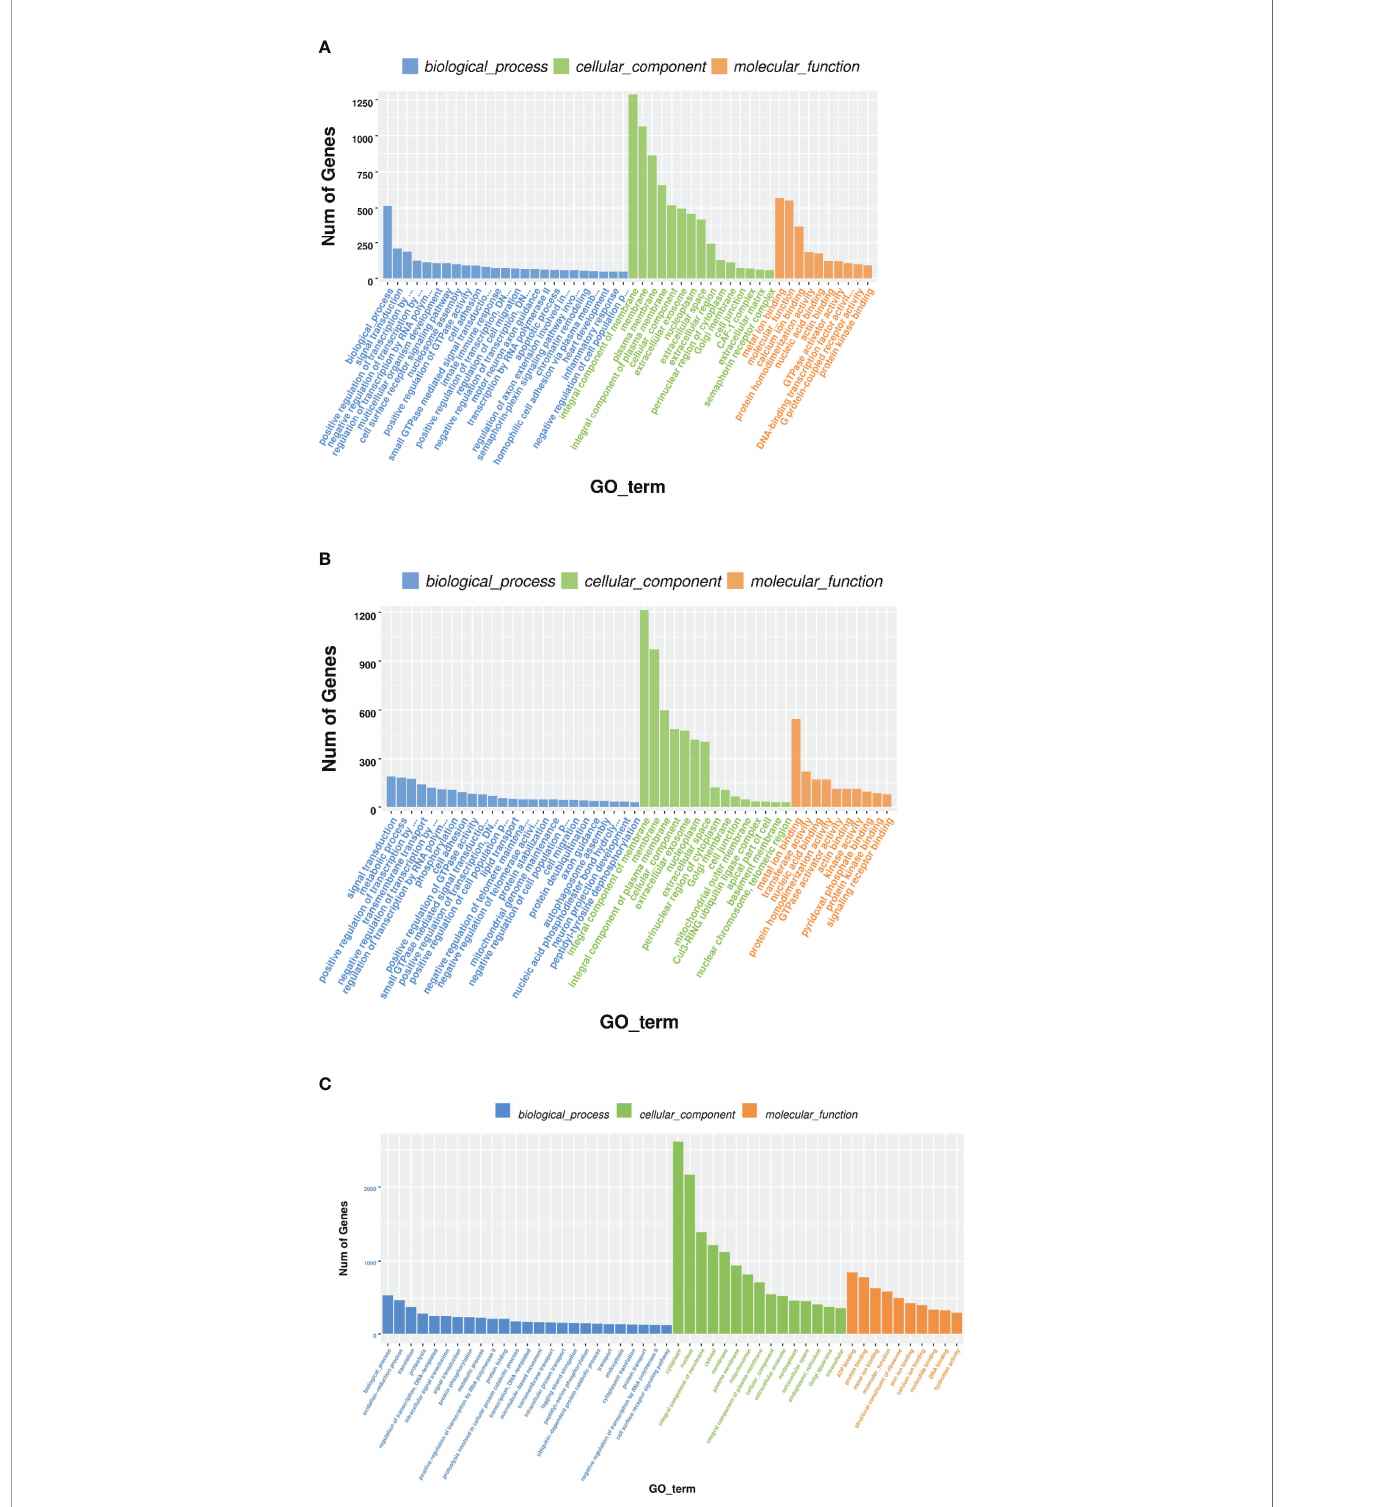
FIGURE 4 | GO enrichment of target genes of DEMs. The x-axis is the rich factor, which indicates the proportion of genes in total genes in a GO term. The y-axis is the gene functional classi fi cation of GO. Various colors of plots indicate different values of − log 10 (P-value). Plot diameter represents target gene numbers in a GO term. (For interpretation of the references to color in this fi gure legend, the reader is referred to the Web version of this article.). (A) HT VS NT, (B) LO vs NT, (C) HL vs